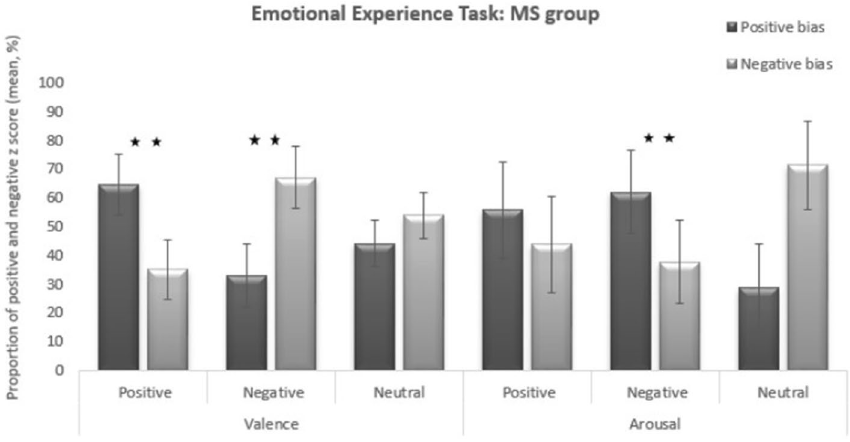
Figure 4. Subjective evaluation emotional experience for positive, negative, or neutral IAPS pictures: positive and negative bias in the MS group for valence and arousal (dispersion analysis). *Significant difference at p < 0.05; **Significant difference at p <